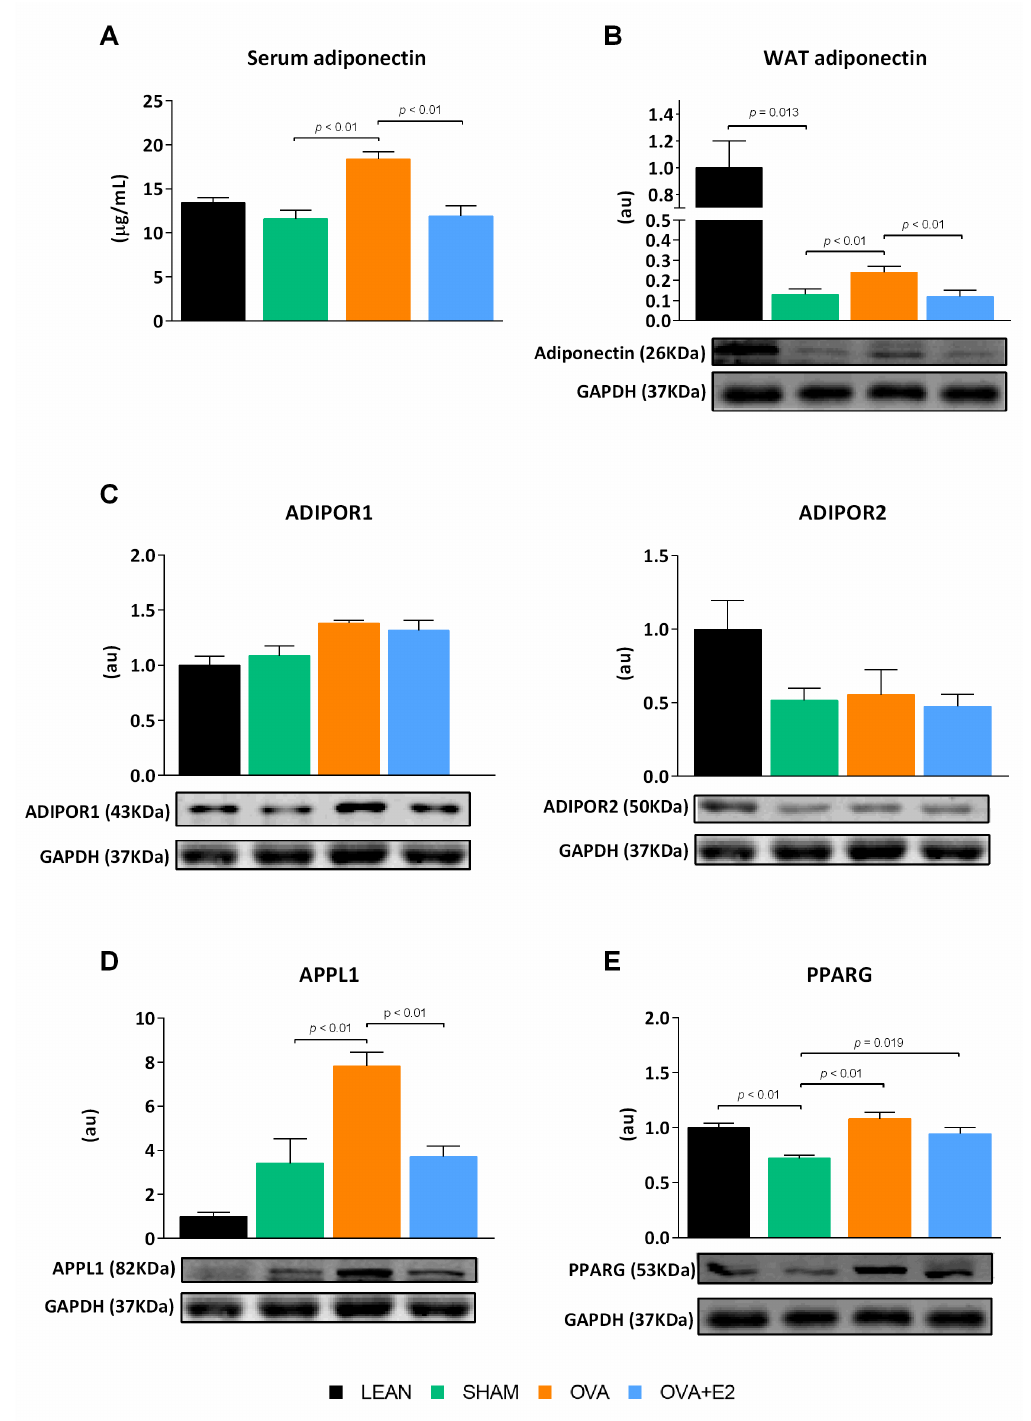
Figure 6. Ovariectomy and E2 treatment effects on adiponectin and mediators of adiponectin signaling pathway in female ZDF rats. ( A ) Serum adiponectin levels. WAT protein levels of ( B ) adiponectin, ( C ) ADIPOR1 and ADIPOR2, ( D ) APPL1, ( E ) PPARG. ADIPOR, adiponectin receptor protein; APPL1, adaptor protein, phosphotyrosine interacting with PH domain and leucine zipper 1; PPARG, peroxisome proliferator activated receptor gamma. Protein bands were normalized to loading control GAPDH protein intensity and expressed in arbitrary units (au) related to LEAN group. Values are expressed as the mean ± SEM. Differences between obese-diabetic (SHAM) and control (LEAN) animals were analyzed by Student’s t -test. Differences between obese-diabetic groups with different hormonal manipulation were analyzed by One-way ANOVA with Fisher’s LSD post-hoc